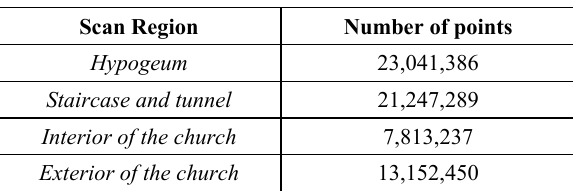
Figure 14. Dense point cloud for external part of the Saint John Church from UAV